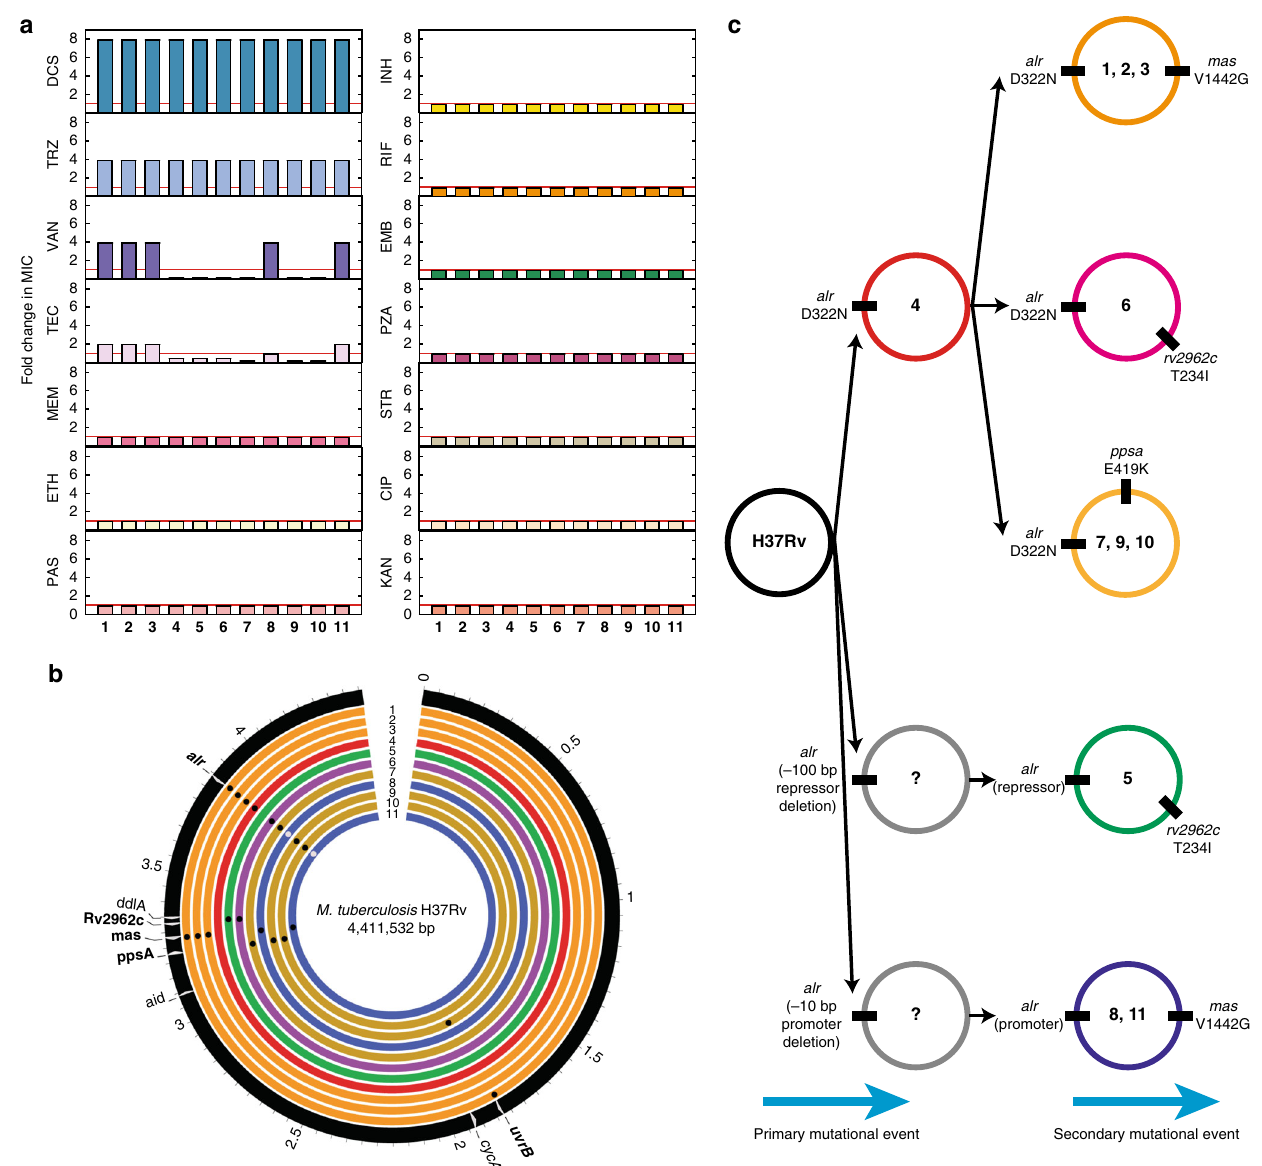
Fig. 1 Drug susceptibility pro fi le of the DCS R strains, distribution of DCS R mutations and evolution of resistant strains. a Drug susceptibility pattern of DCS- resistant mutants (MIC 90 fold change DCS R /parent strain). Drug abbreviations used: DCS D-cycloserine, TRZ terizidone, VAN vancomycin, TEC teicoplanin, MEM meropenem, INH isoniazid, RIF rifampicin, EMB ethambutol, PZA pyrazinamide, STR streptomycin, CIP cipro fl oxacin, KAN kanamycin, ETH ethionamide, PAS para-aminosalicylic acid. The MIC 90 for DCS of the parent, DCS S strain was 6.25 µ g mL − 1 . The data are representative of three independent experiments. b Genome visualization illustrating the SNPs identi fi ed in the DCS R strains compared with the parent, DCS S strain. Moving from the outer to innermost ring, genome reference is indicated in black, with genes harboring SNPs or representing DCS targets highlighted in white, followed by DCS R strains 1 – 11. Presence of non-synonymous SNPs is represented with black dots, while SNPs within the promoter region of the alr gene are colored in gray. Names of genes with identi fi ed SNPs have been highlighted in bold. Mutants have been color-coded, based on the types and polymorphisms observed in the genome. Circular map was generated using Circos 53 . c Schematic representation of evolution of DCS resistance. Circles represent the genomic DNA of each strain and numbers refer to the speci fi c mutant ID. Source data are provided as a Source Data fi